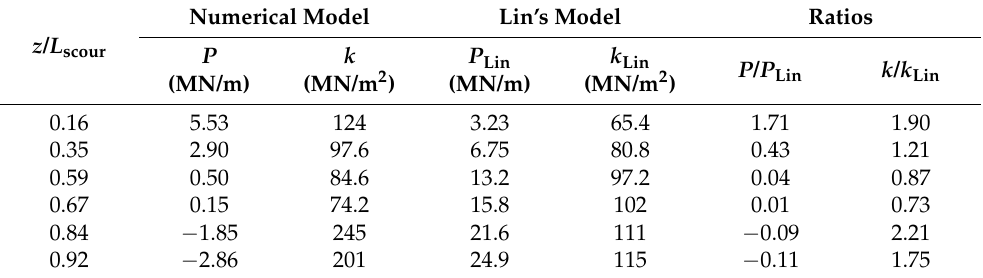
Table 5. Comparisons of soil resistance and initial stiffness ( D = 3 m).